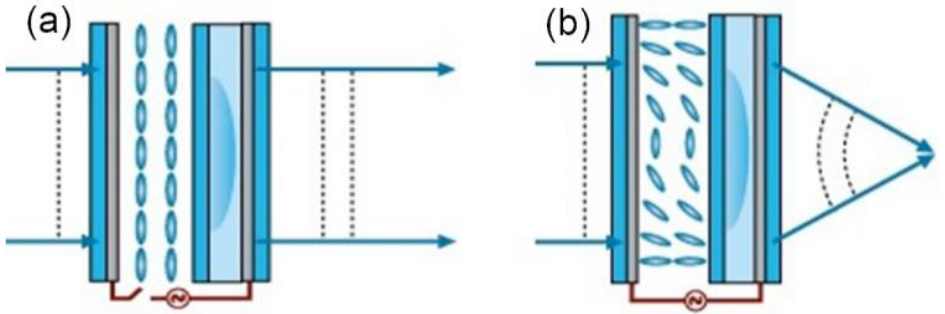
Figure 6. Liquid crystal lens principle. ( a ) Non-active lenses are not energized. The lens has no effect. ( b ) Activated liquid crystal lens and showing the focusing effect. Table 2. List of focal length for different pore sizes under different voltages (unit: cm).